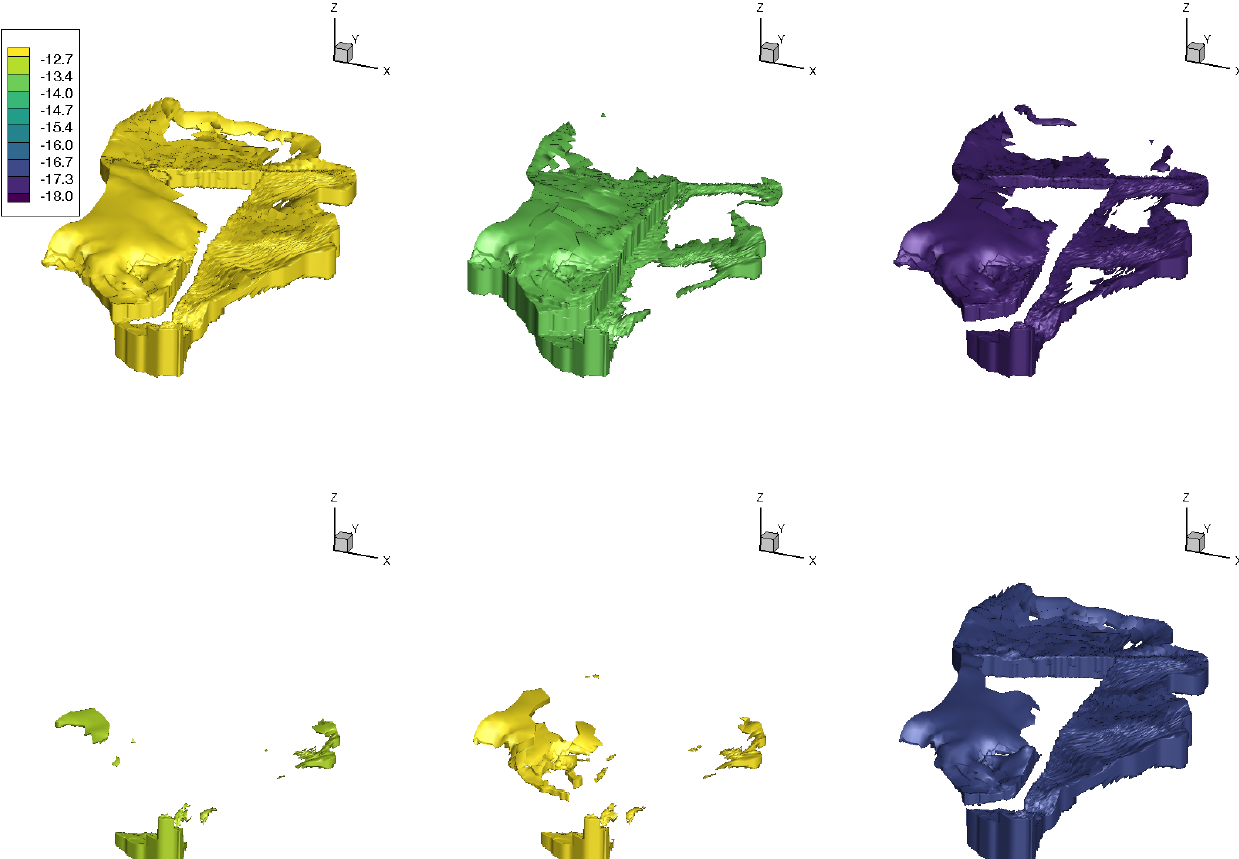
Figure 2. Six examples of distinctively different realizations of the geological layer Lettenkeuper. Color shows the natural logarithm of the saturated hydraulic